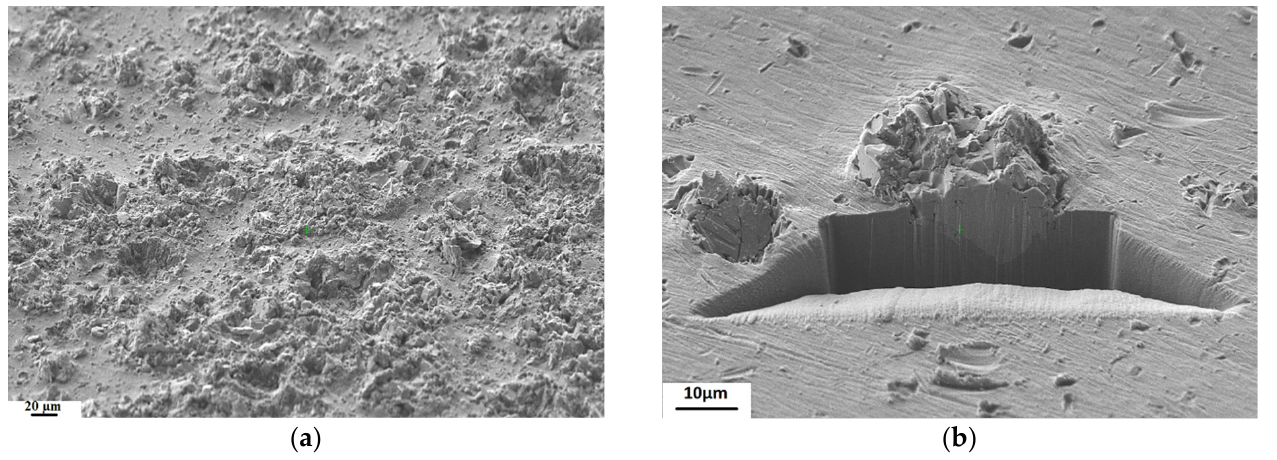
Figure 9. SEM images of Ti 3 AlC 2 sprayed particles at ~730 m/s on Al: ( a ) top view, ( b ) FIB cross-section. For the Ti 3 AlC 2 particles’ lowest velocity, of ~723 m/s, the metallic behaviour is pre- dominant and their interaction with the TA6V substrate creates a weak bond but limits the coating build-up (Figure 10a). Increasing the velocity up to ~780 m/s, the ceramic be- haviour is highlighted, and the kinetic energy is mostly consumed by fragmentation. Also, at a high velocity, the erosion phenomenon is accentuated, limiting the coating thickness.